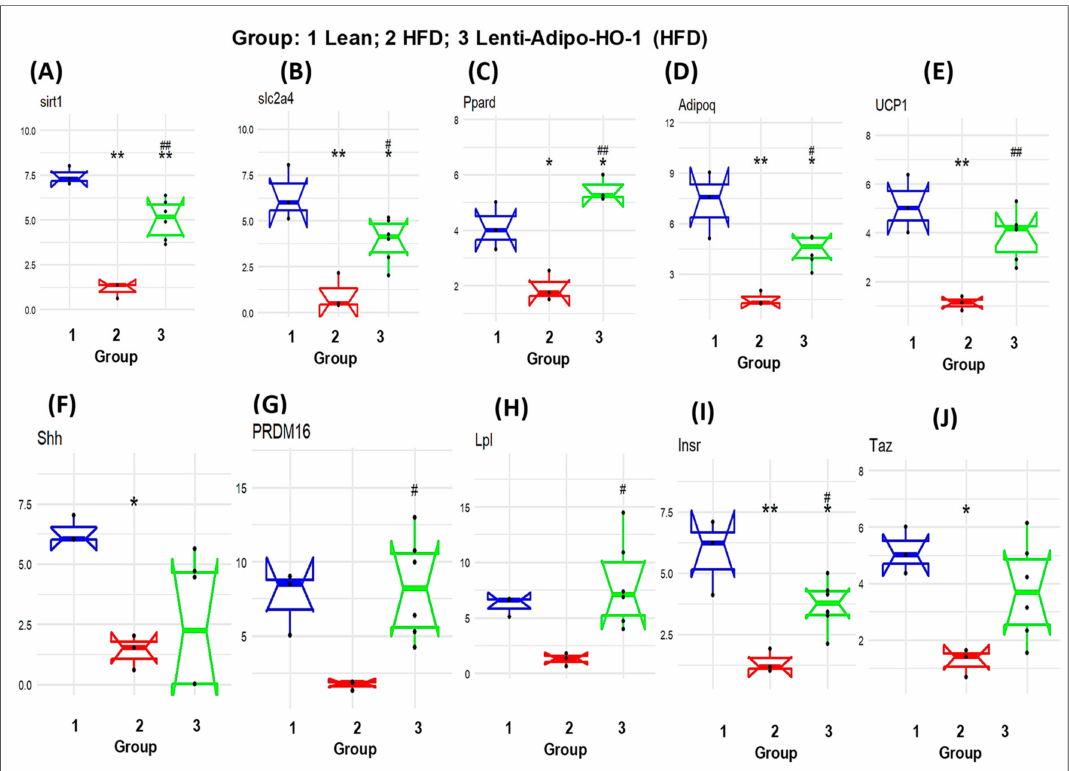
Figure 11. The mRNA expression of (Group 1) mice, HFD (Group 2) mice, and Lnv-adipo-HO-1 (HFD) mice (Group 3). ( A ) sirt1, ( B ) slc2a4, ( C ) Ppard, ( D ) Adipoq, ( E ) UCP1, ( F ) Shh, ( G ) PRDM16, ( H ) Lpl, ( I ) Insr, and ( J ) Taz. ( n = 5, * p < 0.05, ** p < 0.005 vs. lean; # p < 0.05, ## p < 0.005 vs. HFD